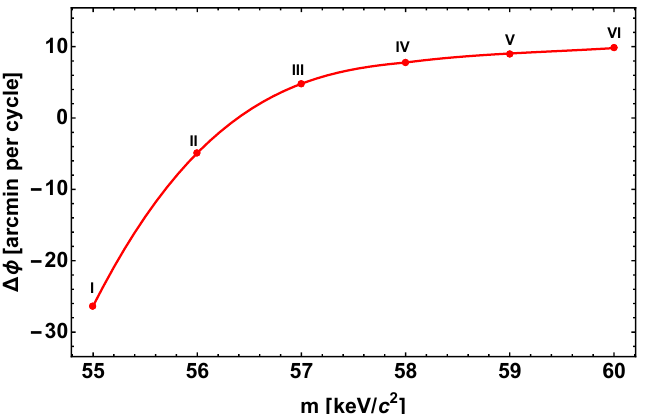
Figure 6. Relativistic periapsis precession ∆ φ per orbit as a function of the darkino mass as predicted by the RAR DM models for the S2 star. The precession is retrograde for mc 2 < 56.4 keV while it becomes prograde for mc 2 > 56.4 keV (see also Table below). Reproduced from [36] with the authors’ permission. Table 1. Comparison of the BH and RAR DM models that best fit all the publicly available data of the S2 orbit. The 2nd column shows the central object mass, M CO . For the Schwarzschild BH model, M CO = M BH , while for the RAR model, M CO = M c , with M c the DM core mass. The 3rd column shows the radius of the central object, r c . For the Schwarzschild BH model, r c is given by the event horizon radius, R Sch = 2 GM BH / c 2 . The 4th column shows the DM mass enclosed within the S2 orbit, 6th columns. The values of the average reduced χ 2 of the best fits, defined as in [34], are given in the 7th column. The last two columns show the model predictions of the periapsis precession of the real orbit, ∆ φ , and of the sky-projected orbit, ∆ φ sky . Reproduced from [36] with the authors’